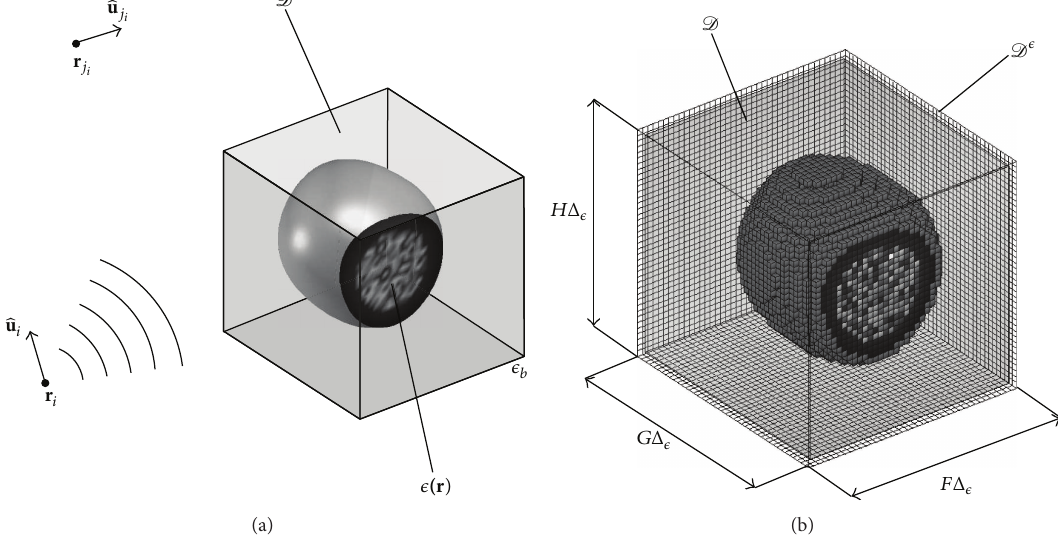
Figure 1: The 3D scattering configuration (a) and the permittivity grid D 𝜖 with the piecewise constant approximation for the permittivity function